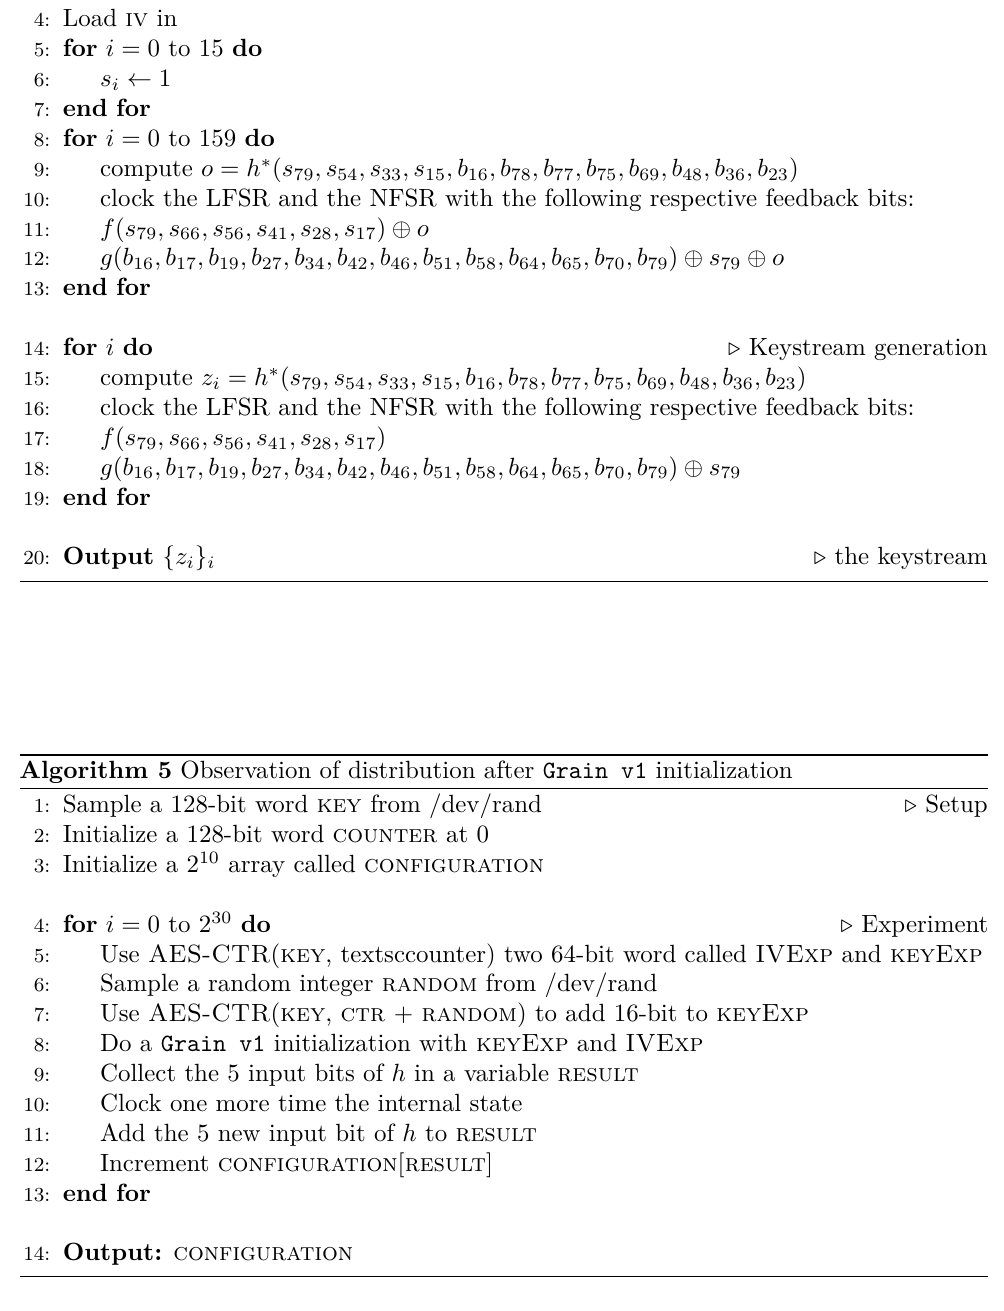
Algorithm 4 The initialization procedure and keystream generation of Grain v1